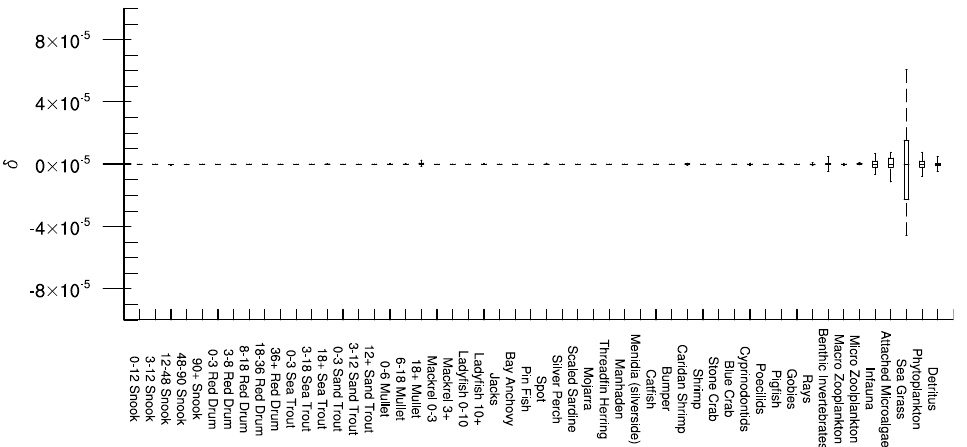
Figure 3. The residuals between absolute biomasses simulated by EwE 6.5 and EwE-F 1.0 for the Tampa Bay model. x axis denotes all state variables in the